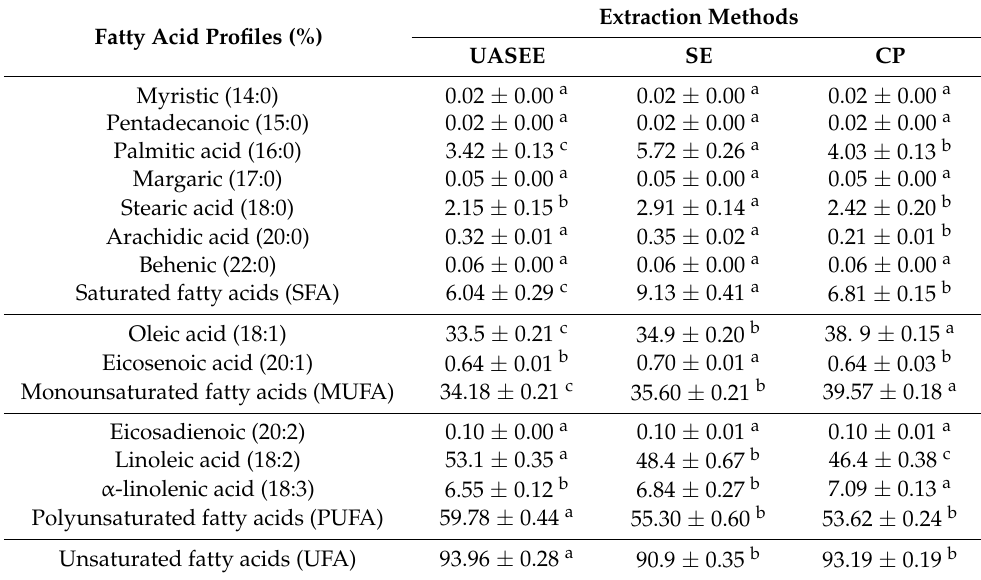
Extraction Methods